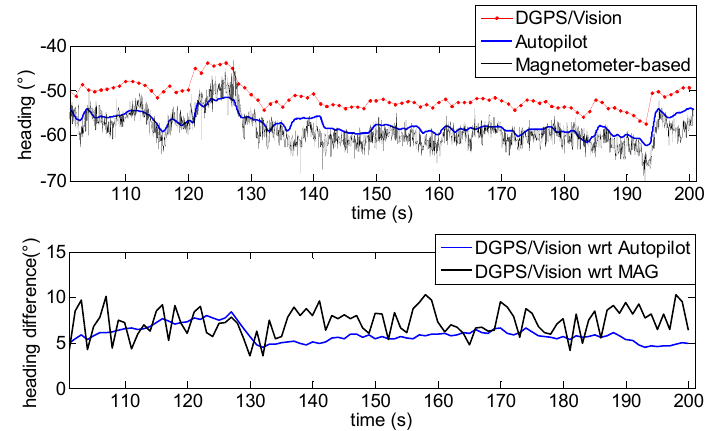
Figure 16. Heading angle as a function of time ( Top ), differences of DGPS/Vision with respect to autopilot and magnetometers ( Bottom ) during the first flight segment (Test 1).